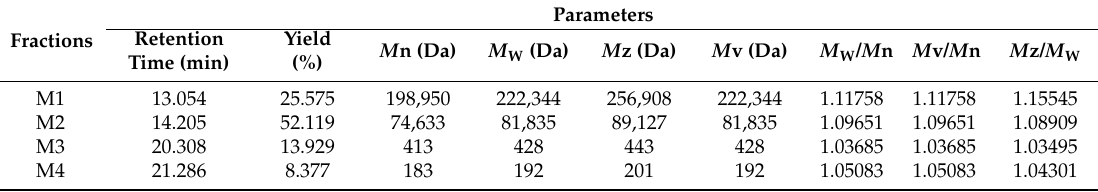
Table 3. Yields and relevant molecular parameters of four peaks of F2 in gel permeation chromatography (GPC)